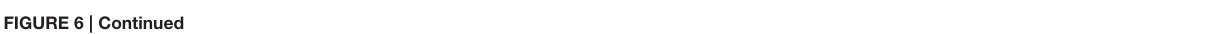
FIGURE 6 | Continued ∆ BcDIM2-16 and ∆ BcHP1-7 knockout transformants. All the strains were grown on a PDA plate at 20 ◦ C for 15 days under dark condition. (C) Pathogenicity assays of the ∆ BcDIM2-16 and ∆ BcHP1-7 knockout transformants of B. cinerea on detached Arabidopsis leaves. (D) Comparison of the hyphal growth rate of the ∆ BcDIM2-16 and ∆ BcHP1-7 knockout transformants. (E) Comparison of the number of conidiophores per plate of ∆ BcDIM2-16 and ∆ BcHP1-7 knockout mutants. (F) Comparison of dry weight of sclerotia produced by ∆ BcDIM2-16 and ∆ BcHP1-7 knockout transformants. (G) Comparison of the lesion diameters of the wild type, ∆ BcDIM2-16 and ∆ BcHP1-7 knockout